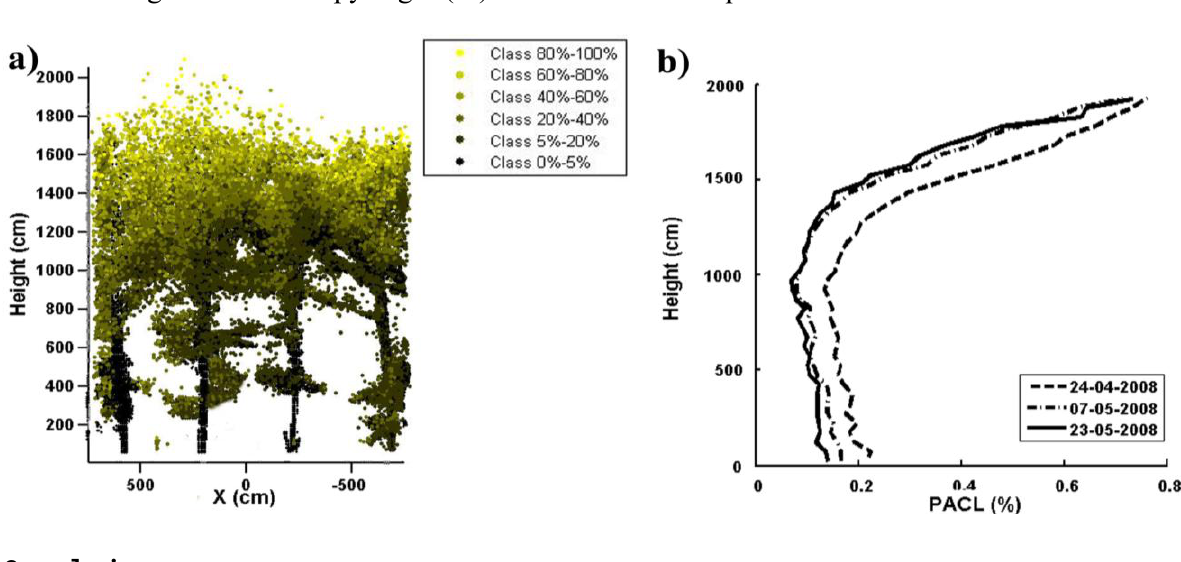
Figure 3. (a) 3D visualization of light interception calculated with the VLIM for one measurement plot on April 24, 2008. (b) Mean vertical light extinction in terms of Percentage Above Canopy Light (%) for the three subsequent time